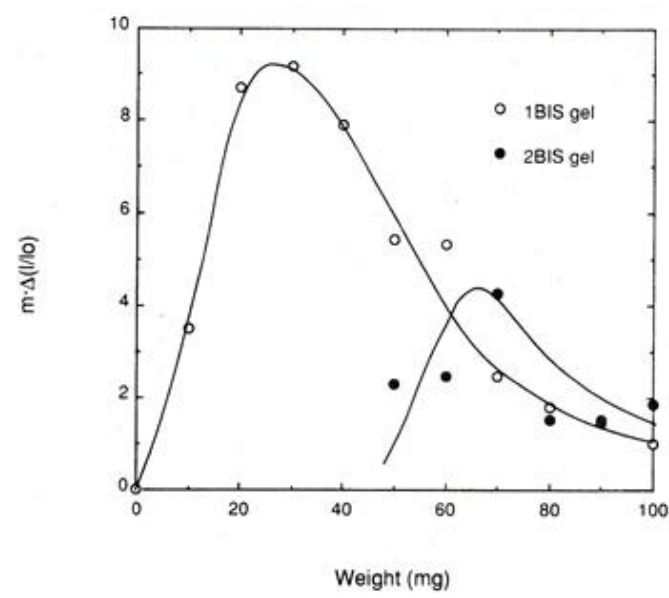
Figure 8. Mechanical work per unit length of PNIPA gels at the transition temperature on heating as a function of applied weight [10].